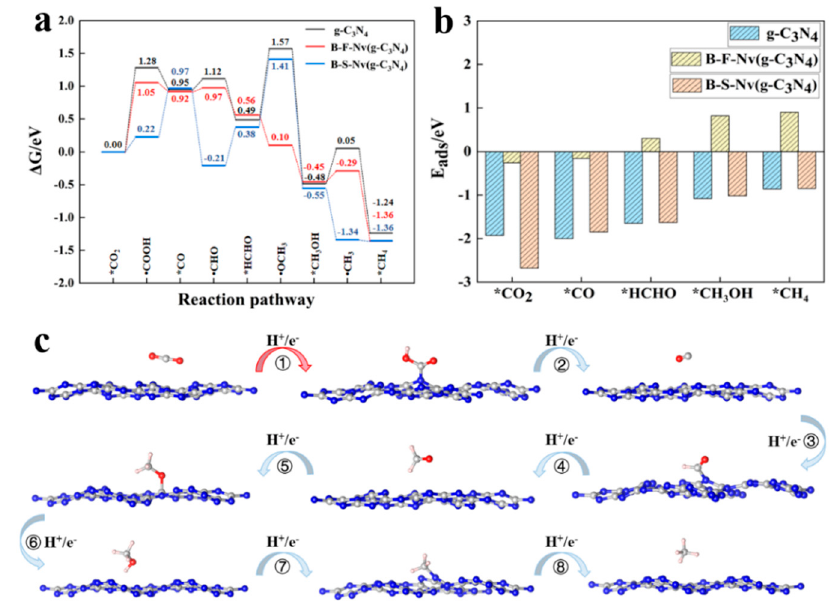
Figure 6. ( a ) Gibbs free energy diagrams of photocatalytic CO 2 reduction and ( b ) adsorption ene-gies of products in different stages of CO 2 reduction for pristine and doped systems. ( c ) The repr-sentative geometries of the stable points in the specific reduction process for CO 2 on g-C 3 N 4 .